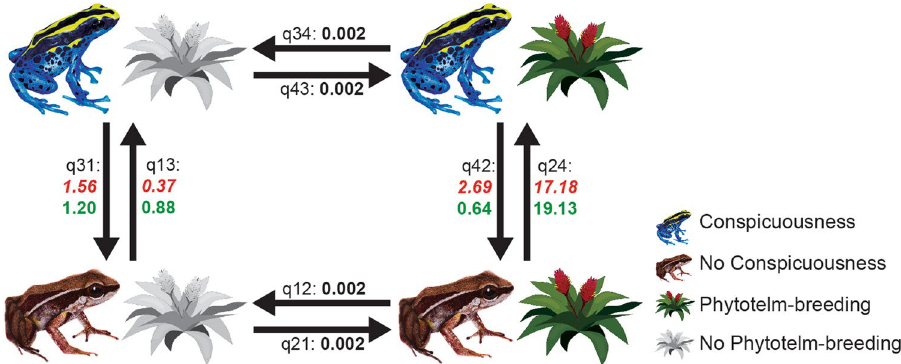
Figure 3. Transition rate estimates from the best dependent model with q34 = q43 = q12 = q21 constraints for both conspicuousness and skin-alkaloids with phytotelm-breeding derived from MCMC analyses. Values in red and italics correspond to the model with conspicuousness traits and values in green (no italics) correspond to the model with skin-alkaloids traits. Note that transition values at q34, q43, q12 , and q21 have the same transition value in both types of models. Illustrations by MJ Tovar-Gil, AM Ospina-L and DL Rivera-Robles. Figure was modified using Adobe Illustrator version 15.1.0 (https:// www. adobe. com/). The image of